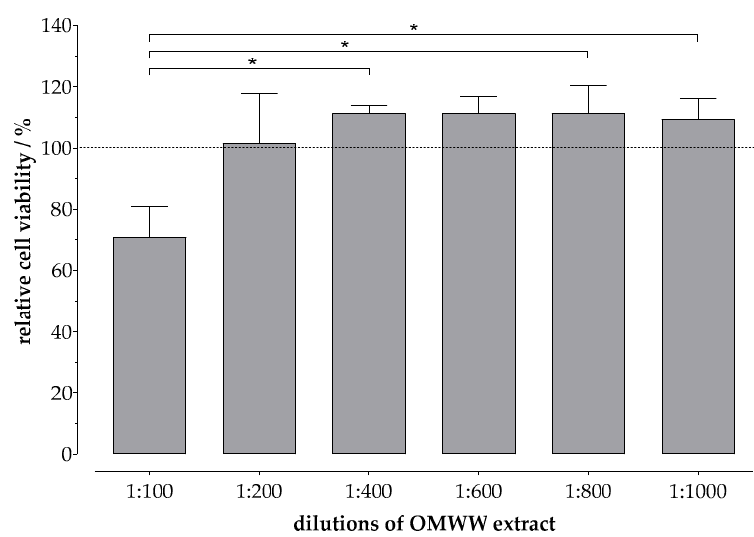
Figure 1. Viability of HaCaT cells (20,000 cells per well, 96-well plate ) after treatment with the OMWW extract dilutions (1:100–1:1000) for 72 h, MW ± SD, n = 3, *p ≤ 0.05 (each 6-fold). Indication of the viability is shown in relation to the untreated control (100% viability).